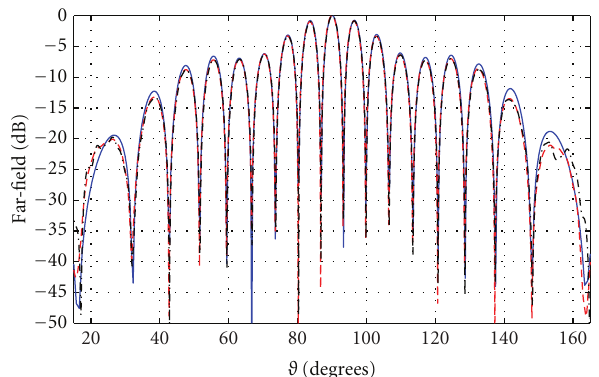
Figure 12: Dual horn, vertical polarization. ϑ cut of the ϑ component of the far field. Blue solid line: proposed approach, when no probe compensation is applied. Red dashed line: approach in [7, 8]. Black dash-dot line: standard, probe-compensated NF-FF